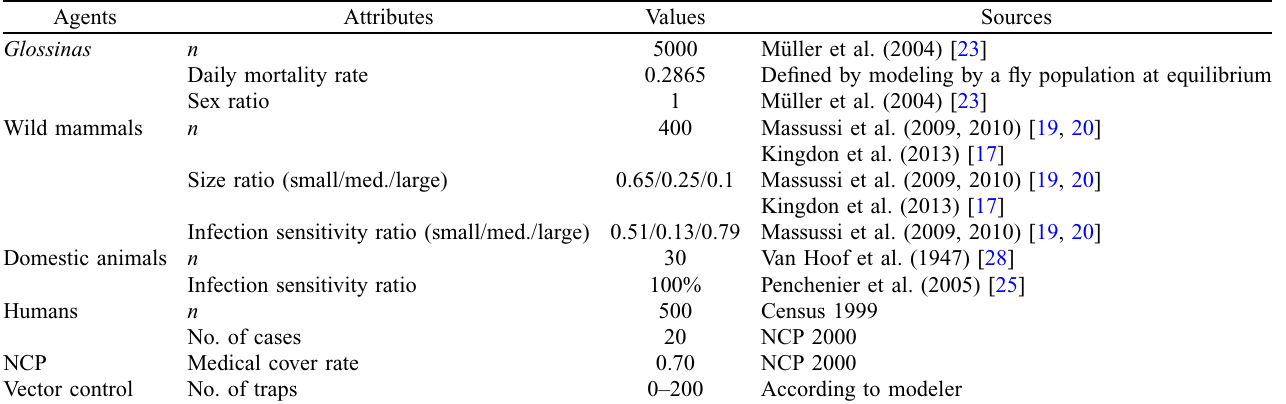
Table 4. Units and initial values for each HATSim